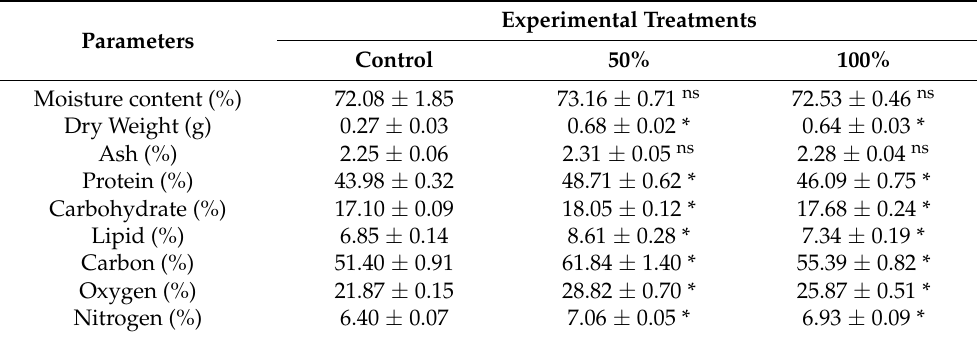
Table 2. Proximate, biochemical and ultimate analysis parameters of C. vulgaris cultivated in different concentrations of mushroom farm